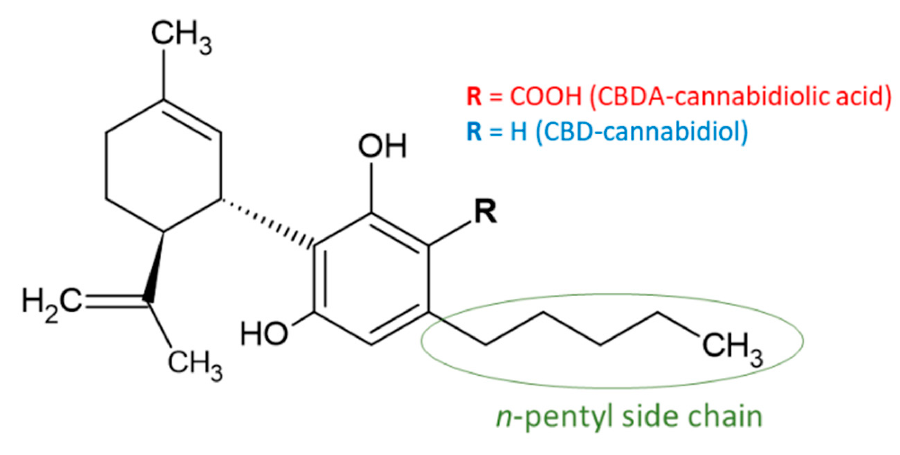
Figure 1. Typical cannabinoid structures (e.g., CBD) differ in carboxylic acid, neutral form, and alkyl side chain [13,16,31].